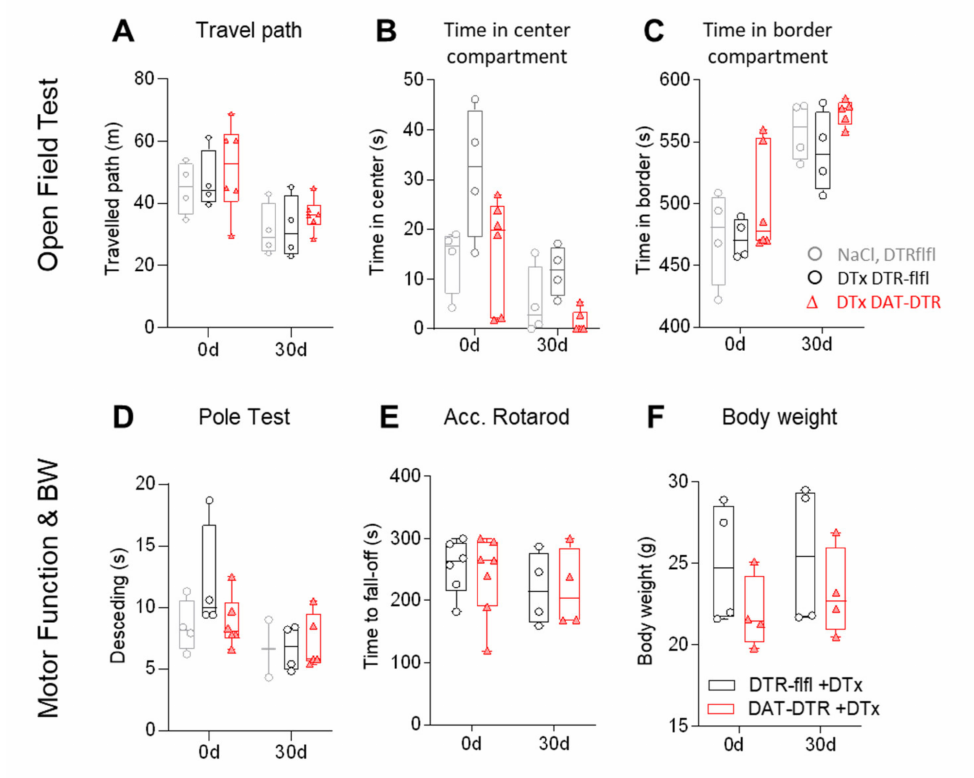
Figure 4. Behavior in DTx-treated mice. ( A – C ) Travel paths and the times spent in the center compartment and the border compartment in a classical open field test (OFT). The behavior was tested at baseline (0d) and 30d after DTx treatment with 0.1 ng/g/d for 5 consecutive days. Exploration of the center dropped in all mice in the 30 d retest without difference between groups. Each scatter is a mouse, sample size n = 4–6. ( D – F ) Motor coordination analysis in the pole test and accelerating Rotarod test and body weights at baseline and 30 d after 5 × 0.1 ng/g DTx. Mice were 13–16 weeks old at the onset of DTx. Sample size n = 4–6 per